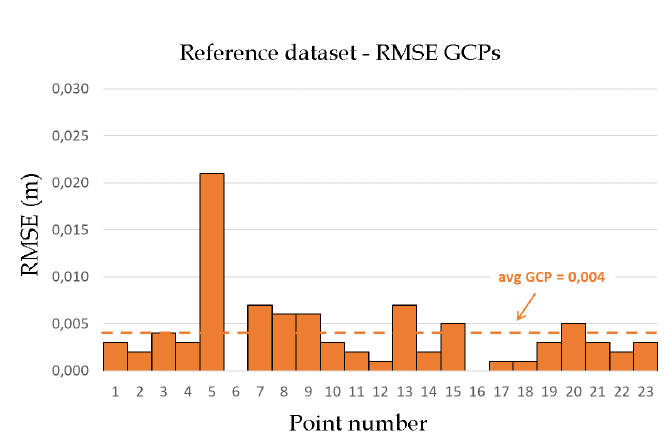
Figure 5. Reference module—RMSE of the ground control